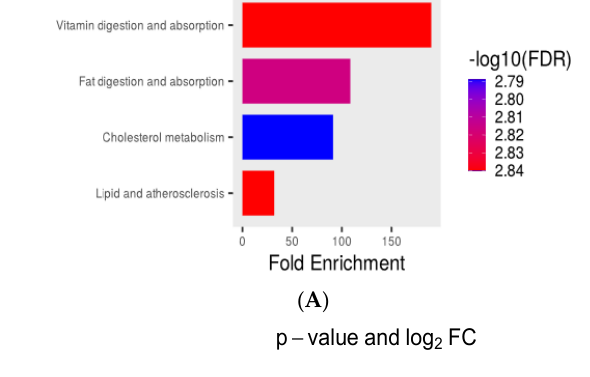
Figure 7. Relationship between the proportion of DHA within polar ( A ) and neutral ( B ) lipids of 40- day-old larvae and the total rate of jaw malformation in cultured Seriola lalandi . The dotted line in figure a represents the linear regression line.